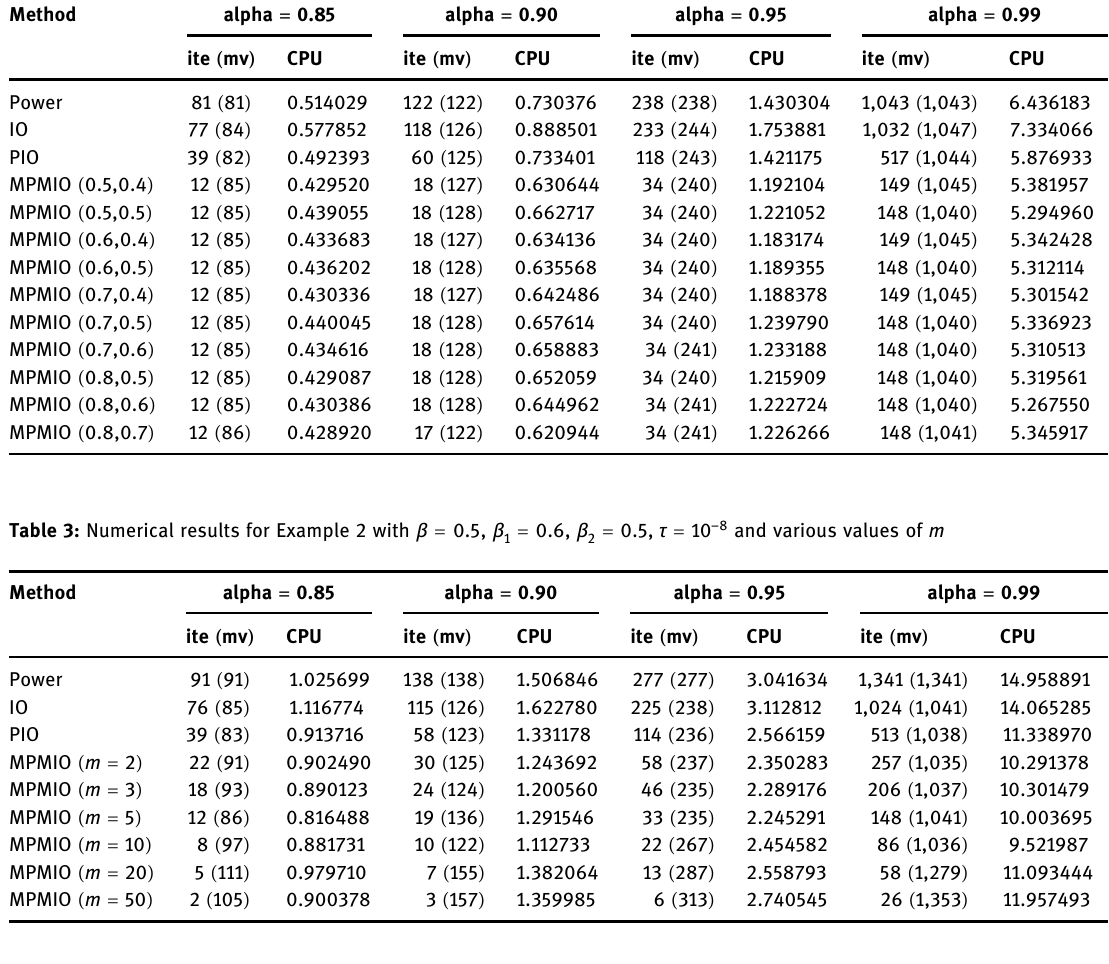
Table 2: Numerical results for Example 1 with m 5 = , β 0.5 = , τ 10 −8 = and various value pairs of β β , Method